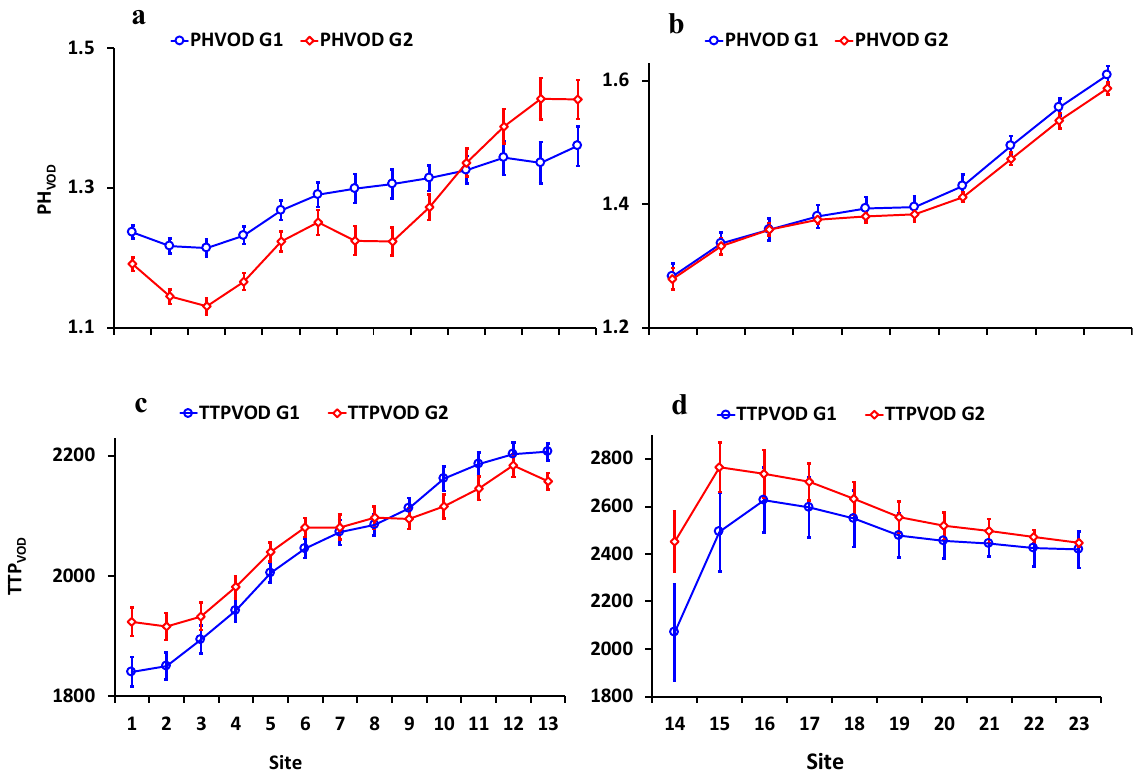
Figure 9. Scatterplots of temporal groups averages (g1: 2003–2005 plus 2007 in blue, and g2: 2013–2016 in red) of peak height of VOD (PH VOD ; a , b ), and thermal time to peak VOD (TTP VOD ; c , d ) in ND ( a , c ) and SD ( b , d ). Error bars show ± 2SE temporal errors. Note the di ff erences in y-axes.